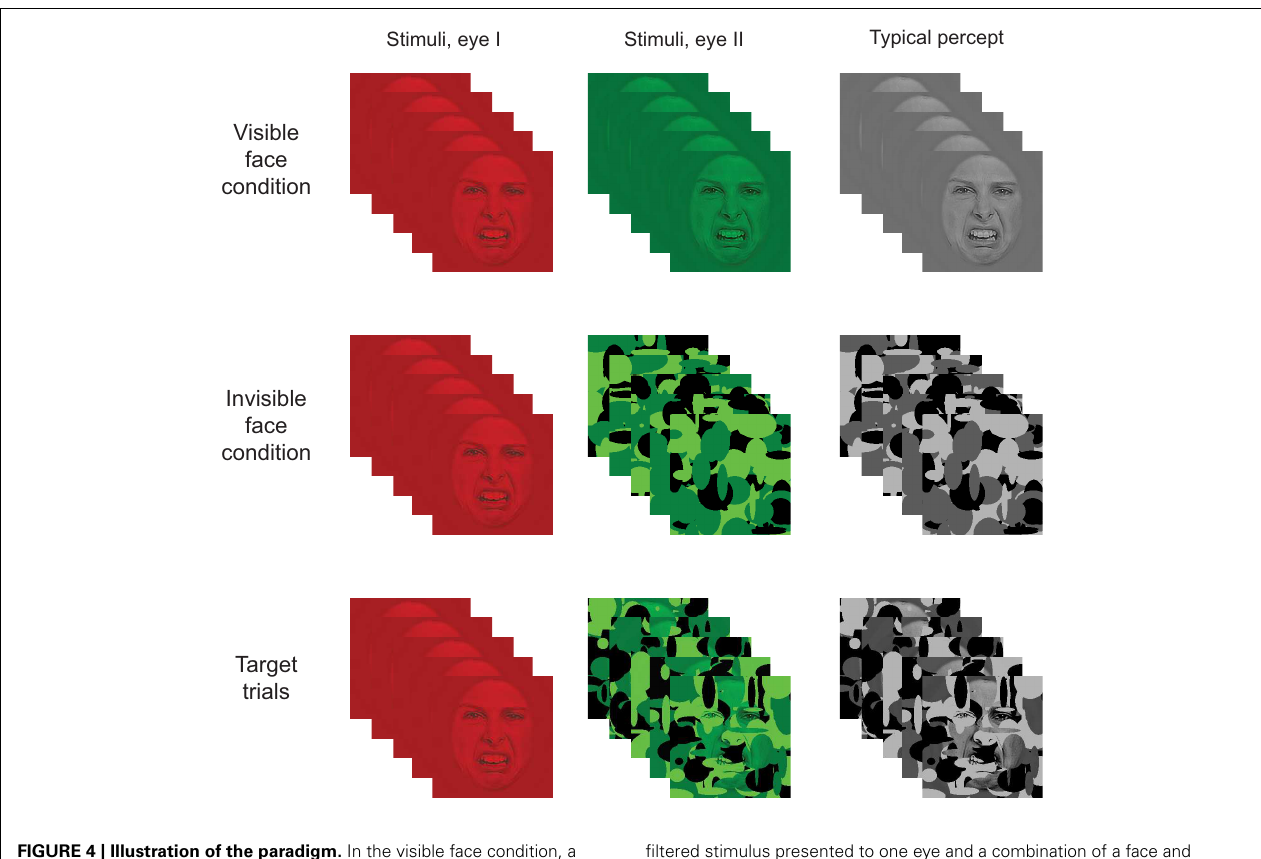
FIGURE 4 | Illustration of the paradigm. In the visible face condition, a stationary SF filtered face image was shown to both eyes simultaneously (i.e., in the red and green layers). In the invisible face condition, an SF filtered face was shown to one eye (i.e., in the red layer) while dynamic noise patterns were presented at 10Hz to the other eye (i.e., in the green layer).Target stimuli consisted of a stationary SF